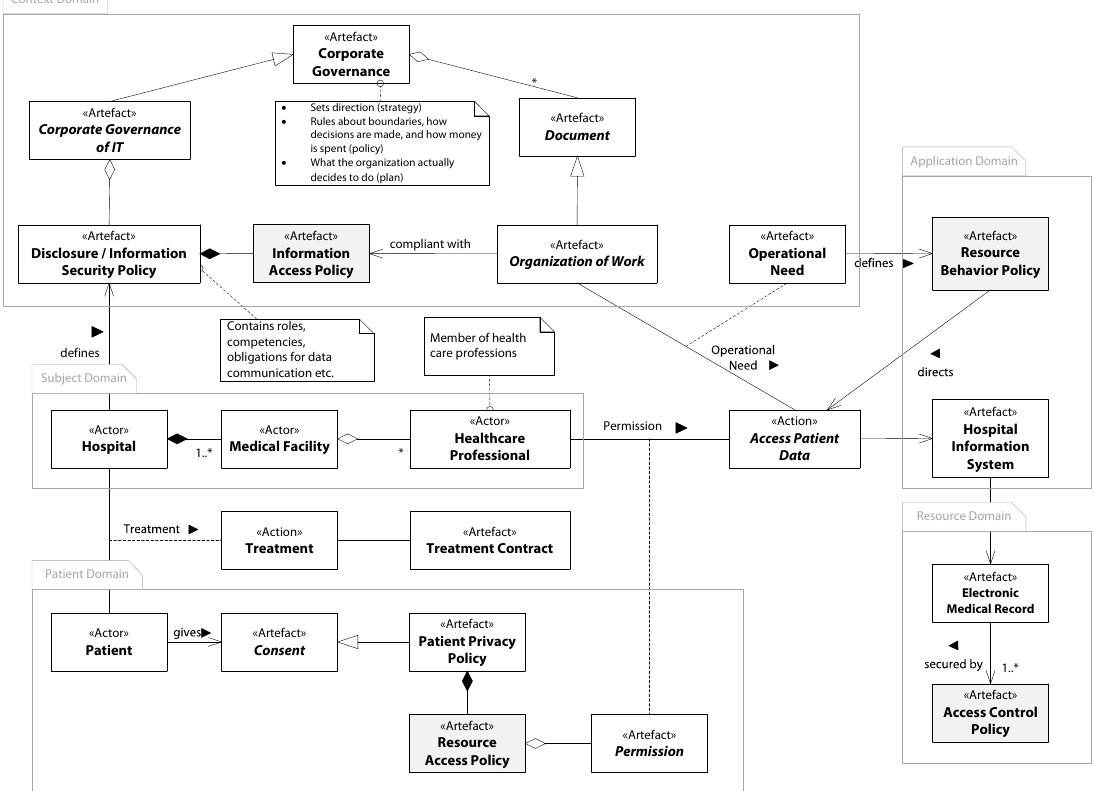
Figure 1. Policy types involved for accessing protected health